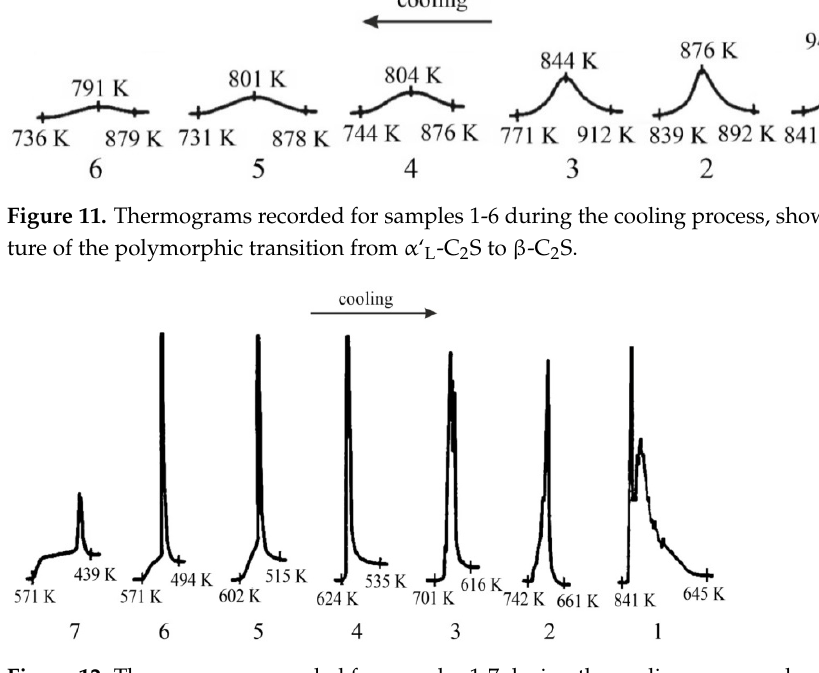
Figure 12. Thermograms recorded for samples 1-7 during the cooling process, showing the temper- ature of the polymorphic transition from β -C 2 S to γ -C 2 S. Table 4. Rate of heat evolution and mean time required for the samples to undergo a complete polymorphic transition (N/A—not applicable, polymorphic transition did not occur). ples. The obtained results are presented in Figures 11 and 12. The data show that increased Sample No.